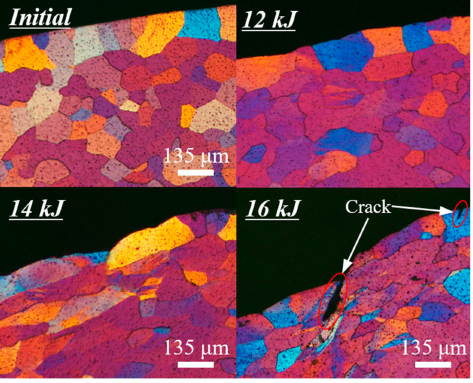
Figure 14. Local enlargements of thinned area (necking area) in position D under various discharge